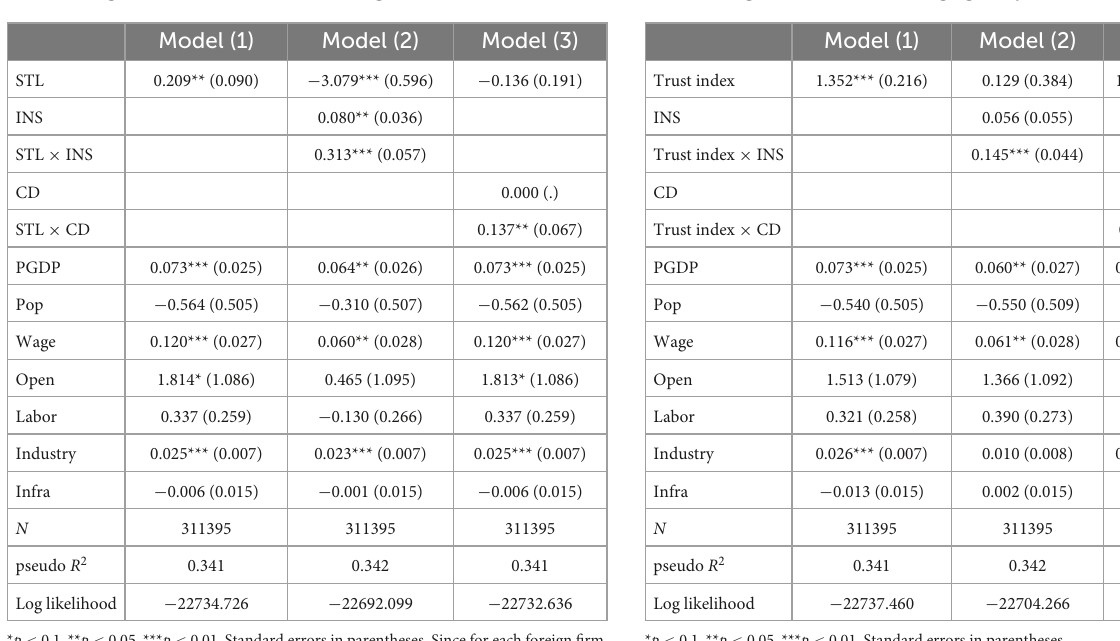
TABLE 2 Regression results of conditional logit model. TABLE 3 Regression results of changing independent variable indicator.